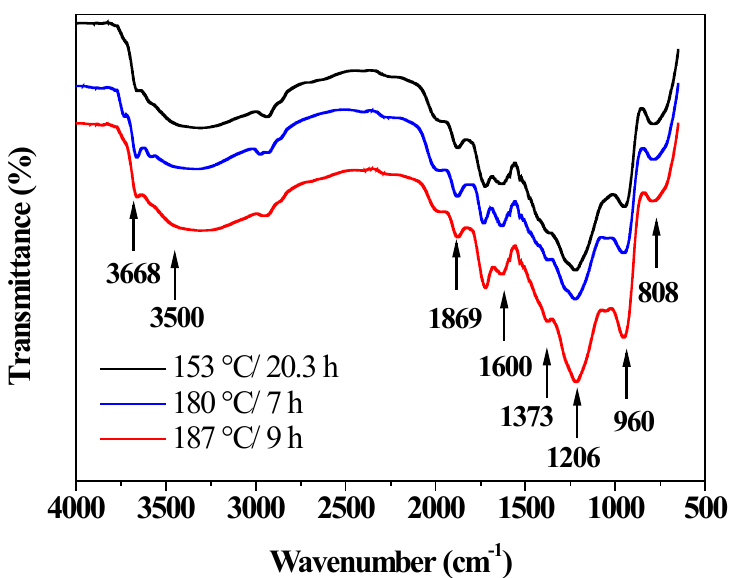
Figure 8. FTIR spectra of BiOI/mordenite composites synthesized at different conditions of temperature and time.